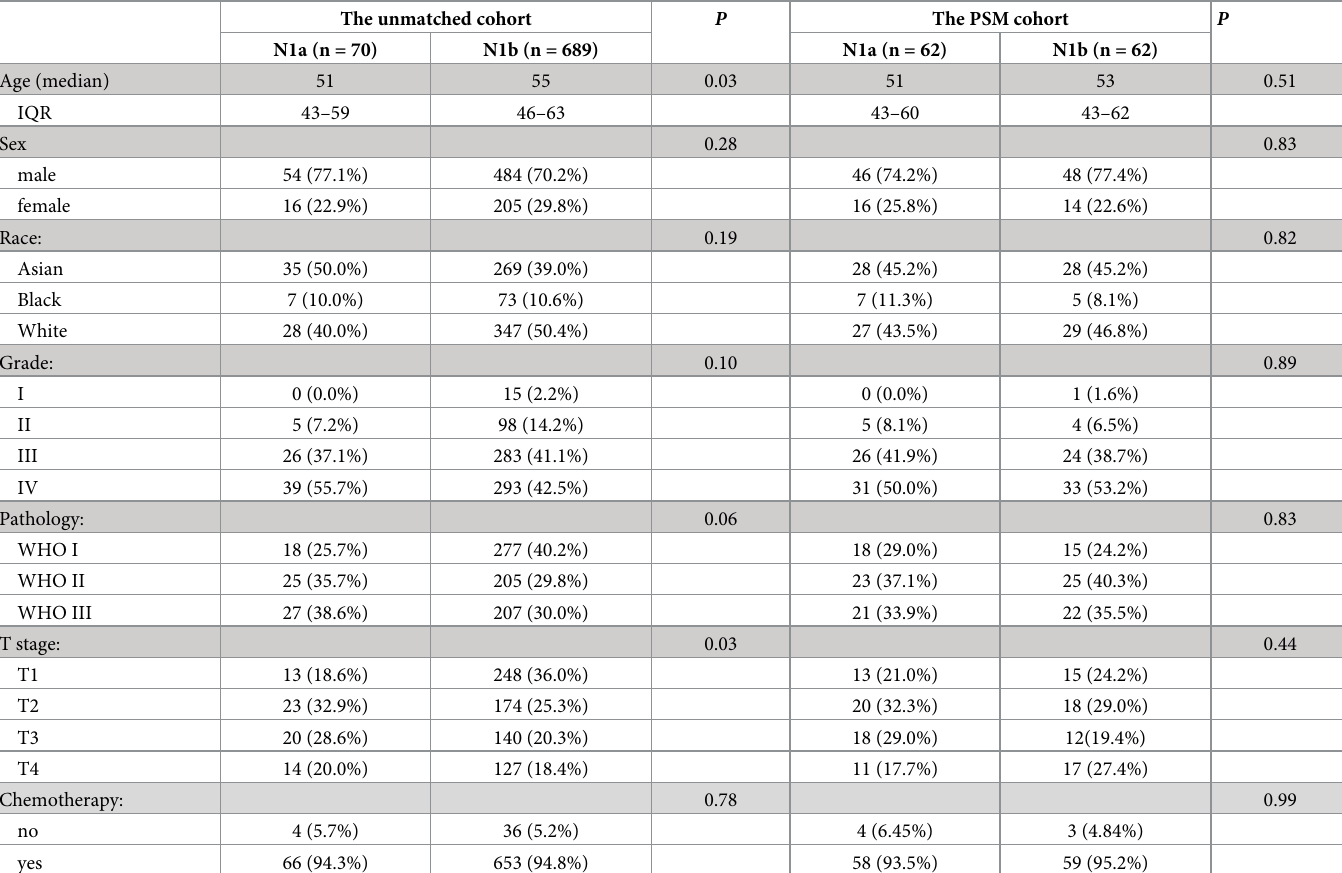
Table 1. Patient